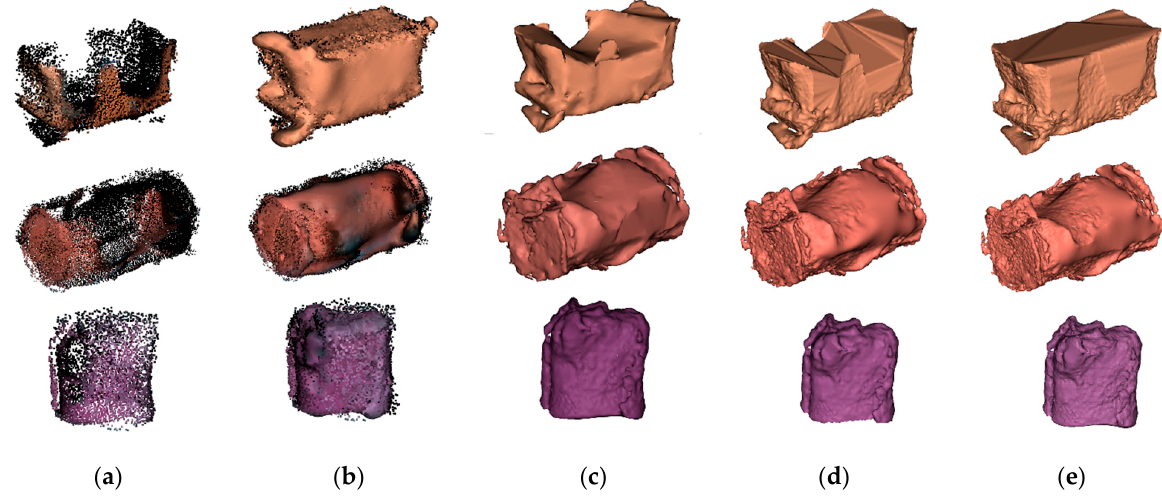
Figure 17. Repair effects of real point cloud models: ( a ) before repair; ( b ) ours; ( c ) DC-AB scanner; ( d ) Meshmixer; ( e ) Geomagic.